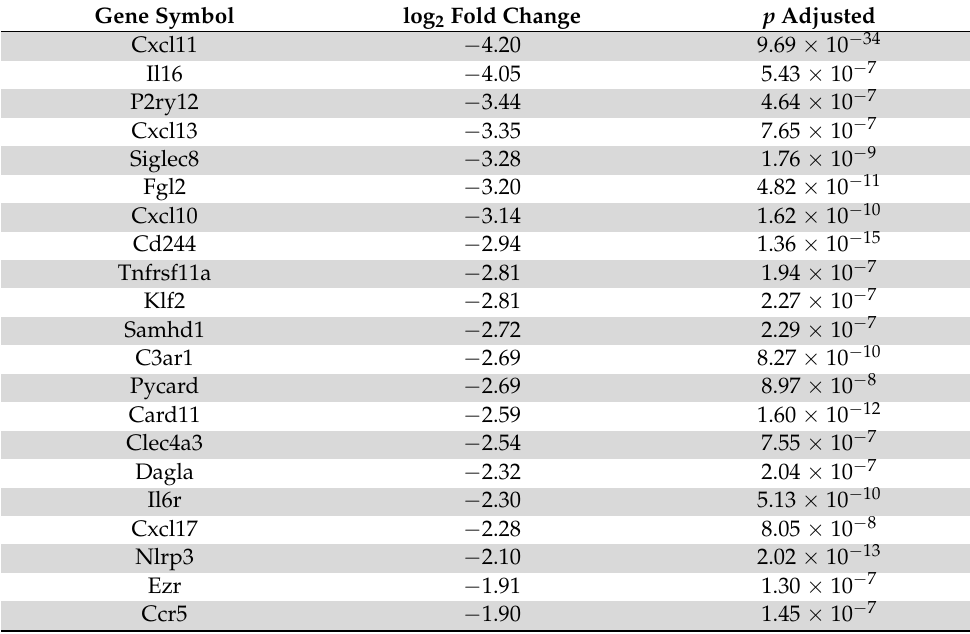
Table 3. Regulation of cytokine